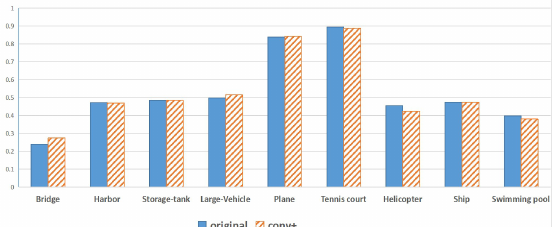
Fig.10 AP of different Classification network. (blue: original; orange: with convolution layer